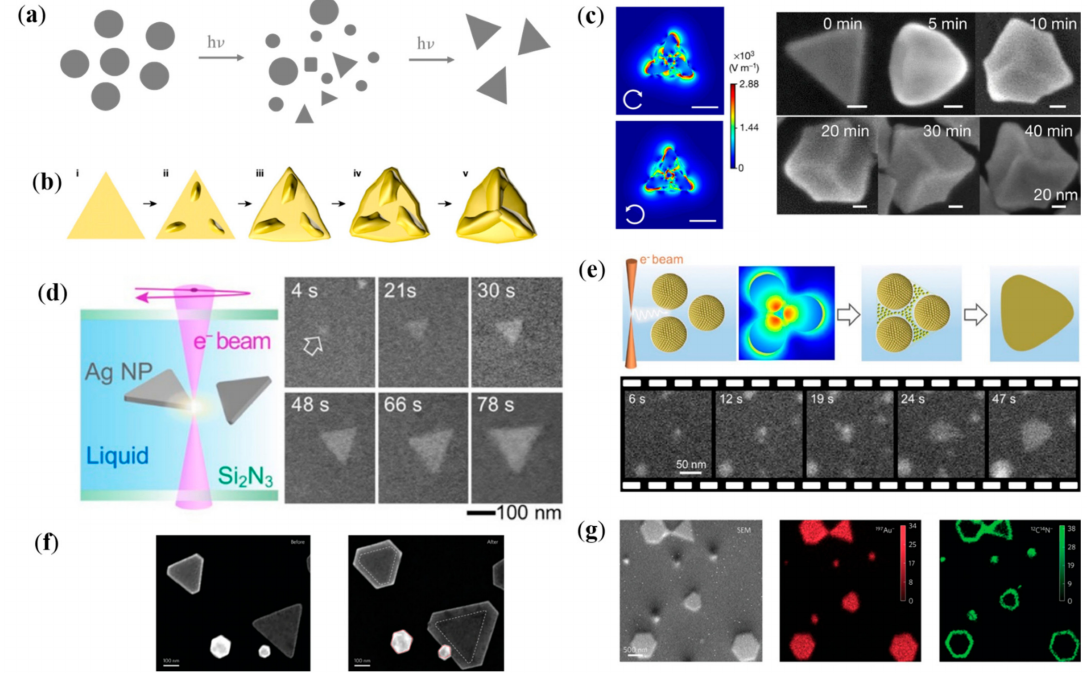
Figure 4. Plasmon-assisted growth of plasmonic nanostructures. ( a ) Schematic illustration of plasmon- assisted conversion of Ag NPs to nanoprisms. ( b , c ) Plasmon-assisted synthesis of chiral